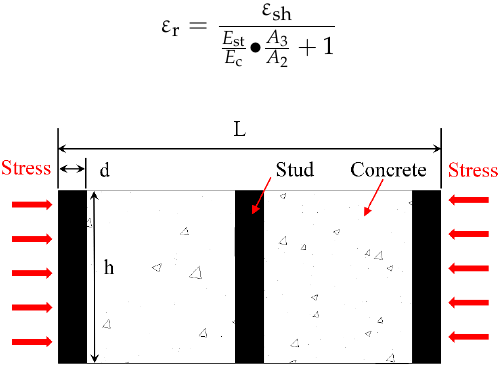
Figure 2. Model for the analysis of Part 1.